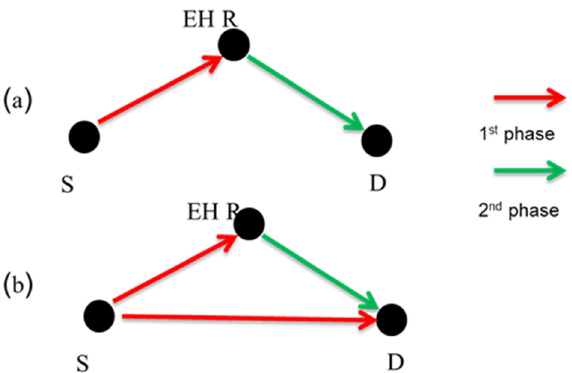
Figure 2. The system model with EH. ( a ) the signal from a source to a destination through the re- lay; ( b ) the signal from a source to a destination through the relay with direct